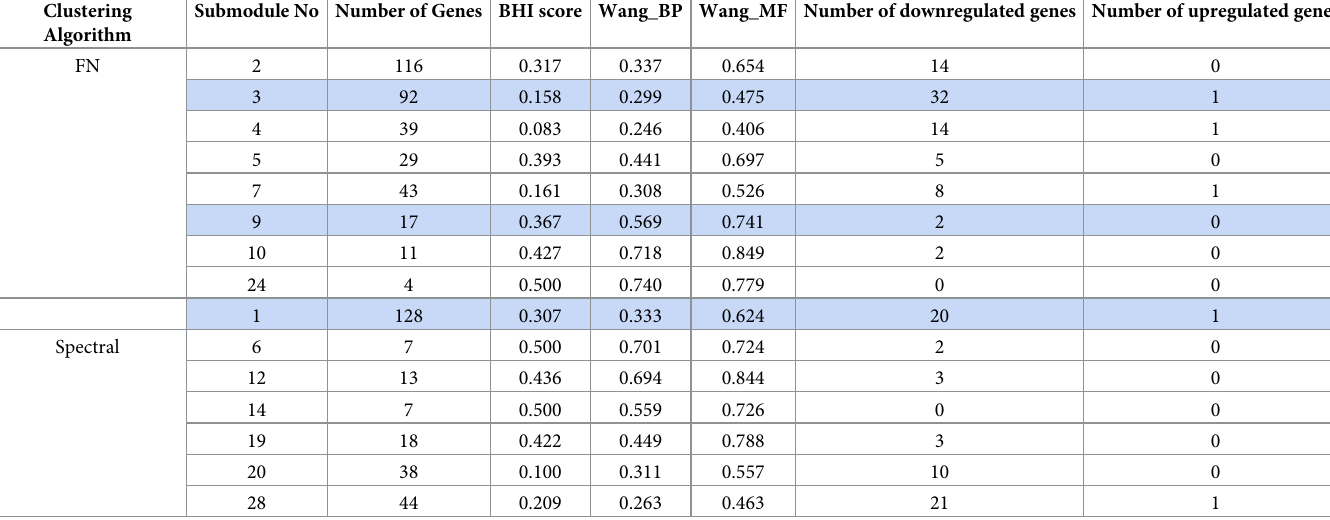
Table 4. Summary of significant submodules detected by the best performing FN and Spectral clustering algorithms. Clustering